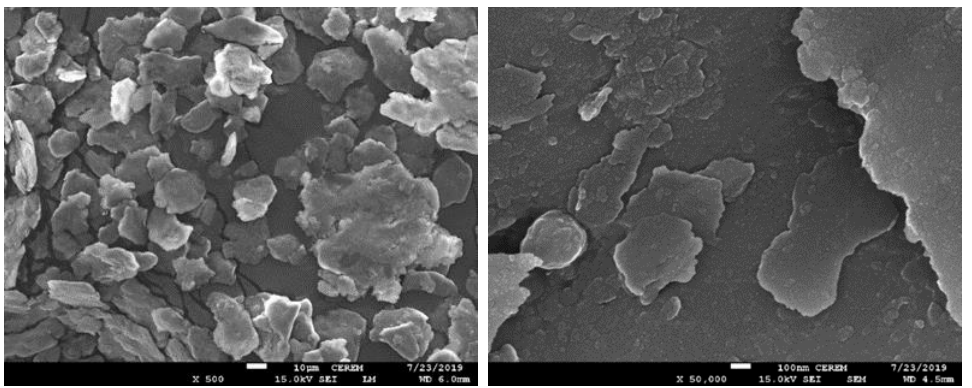
Figure 7. FESEM images for LHLSBM-Al powder.